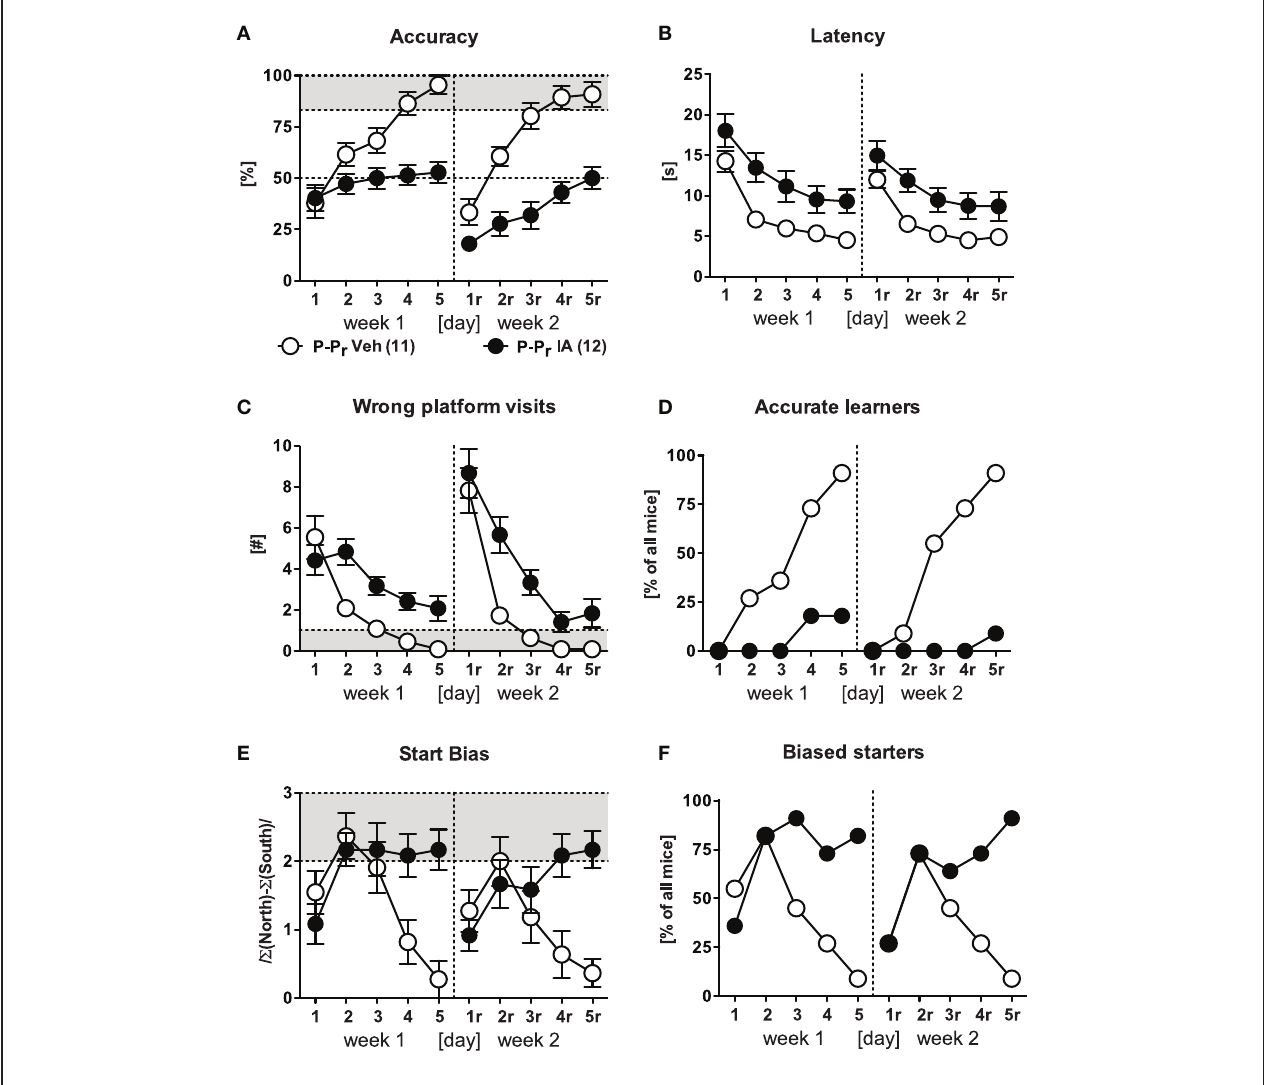
in both weeks [ Treatment: F ( 1 , 21 ) ≥ 6 . 61, p ≤ 0 . 008]. Noteworthy IA group learned to reduce wrong platform visits over time which was indicated by the parallel regress in both groups. (E,F) The high start bias and the high number of bias starters at the end of each week indicated that the IA animals developed an alternative response to solve the task (for details see the